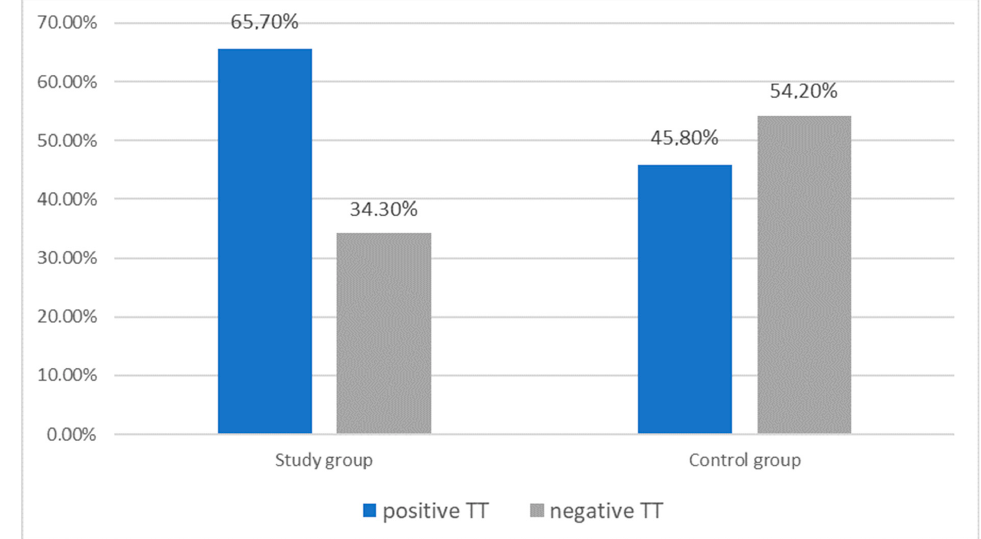
Figure 3. Characteristics of the study ( n = 35) and control ( n = 24) group according to the tetany test result. There was no statistically significant differences ( p > 0.05).